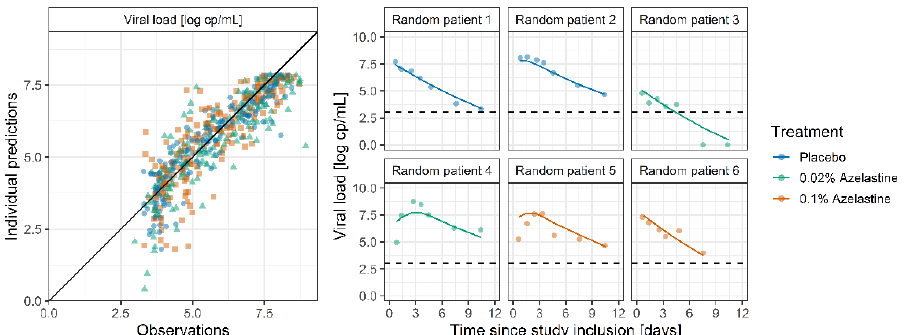
Figure 2. Goodness ‐ of ‐ fit plots for the PK ‐ virus kinetic model ( left ) showing individual predictions vs. observations excluding negative test results (84.1% of which were predicted to be below the lower limit of quantification of 3.02). The black line indicates the line of identity. Exemplary plots ( right ) for two randomly drawn patients per study arm. Points indicate observations. Lines indicate individual model predictions. Observations below the LLOQ were set to 0 log cp/mL. Dashed lines indicate the LLOQ.